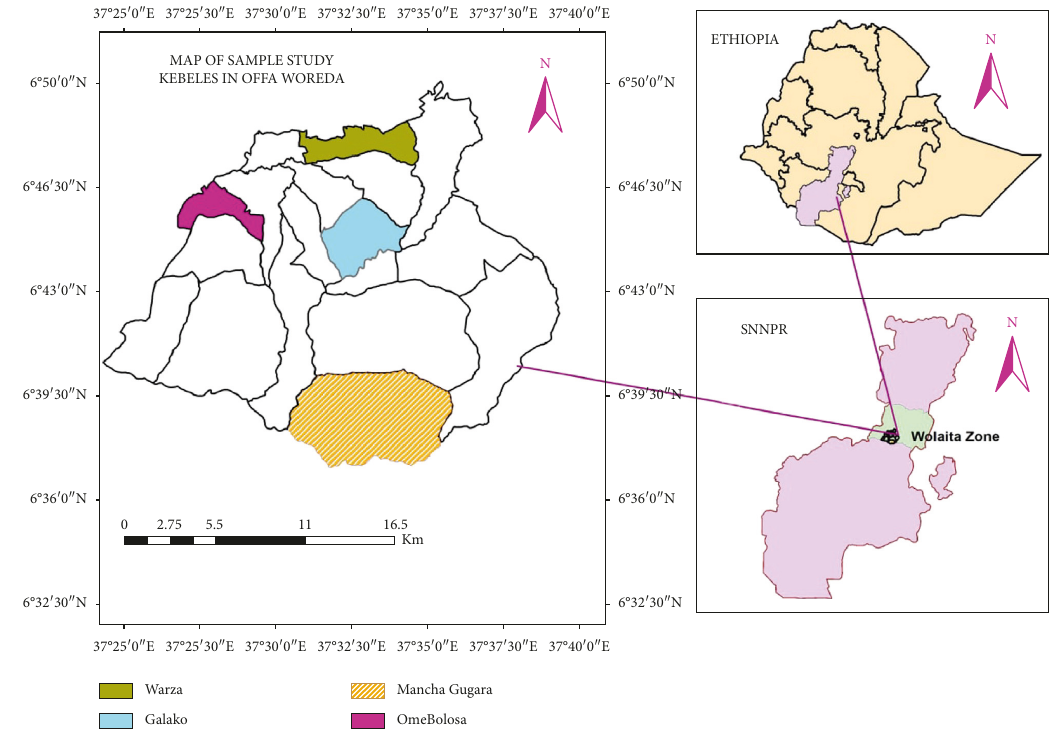
Figure 2: A map of the study area (source: Ethiopia GIS version 10.1 software,